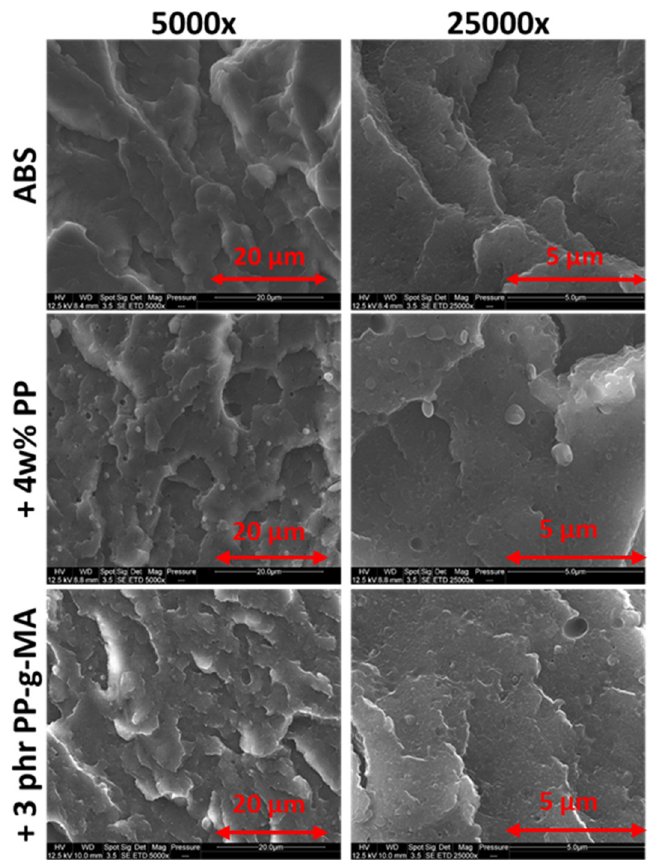
Figure 7. Nodular morphology of PP within ABS at 4 wt% with and without PP-g-MA- two magnifications.